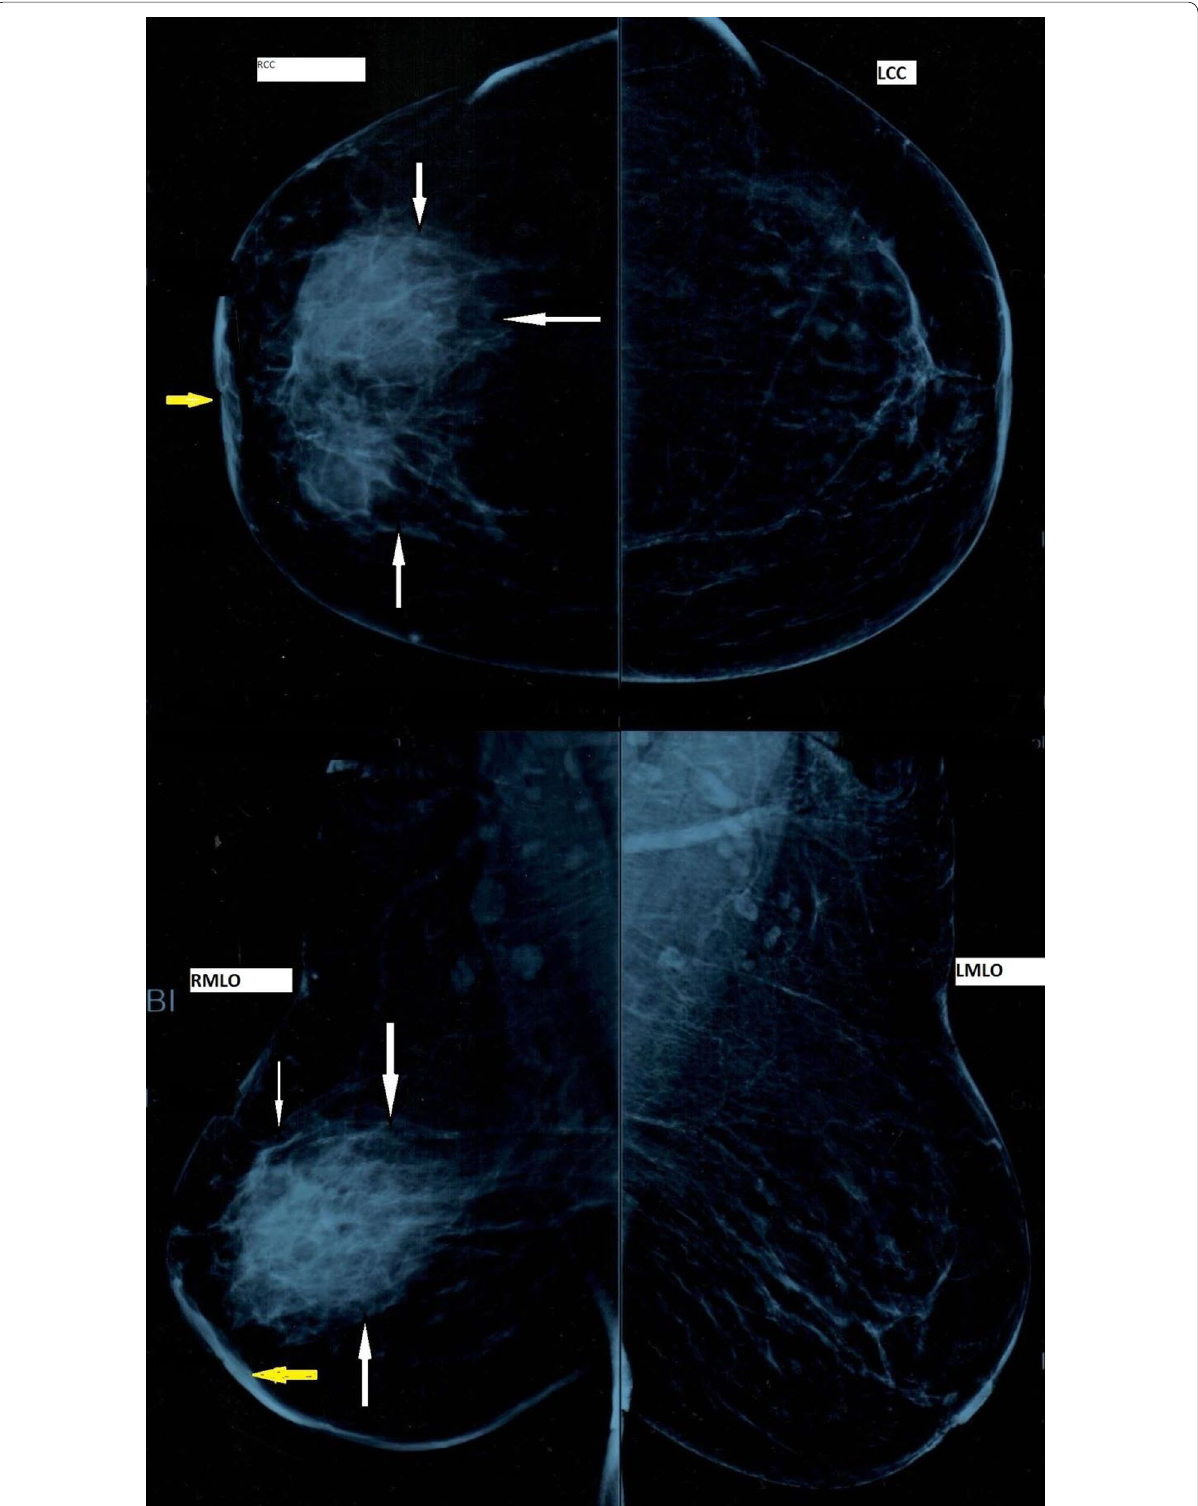
Fig. 5 Mammogram showing ill-defined irregular opacity in right breast (black arrows) with overlying skin thickening (yellow arrow) labeled as BIRADS 5. HR USG revealed ill-defined irregular heterogeneous lesion that was divulged as inflammatory lesion on Trucut biopsy in a patient of 42 years of